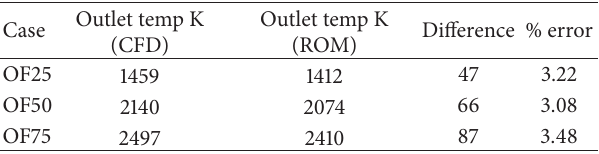
Table 5: Comparison of CFD and ROM results for average outlet